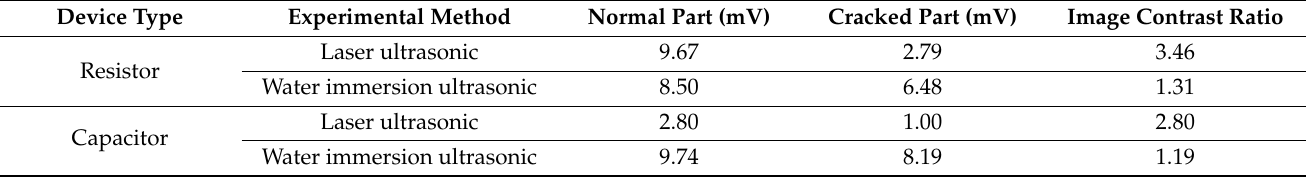
Table 3. ICR and the average value of the proposed laser ultrasound method and conventional water immersion ultra- sound